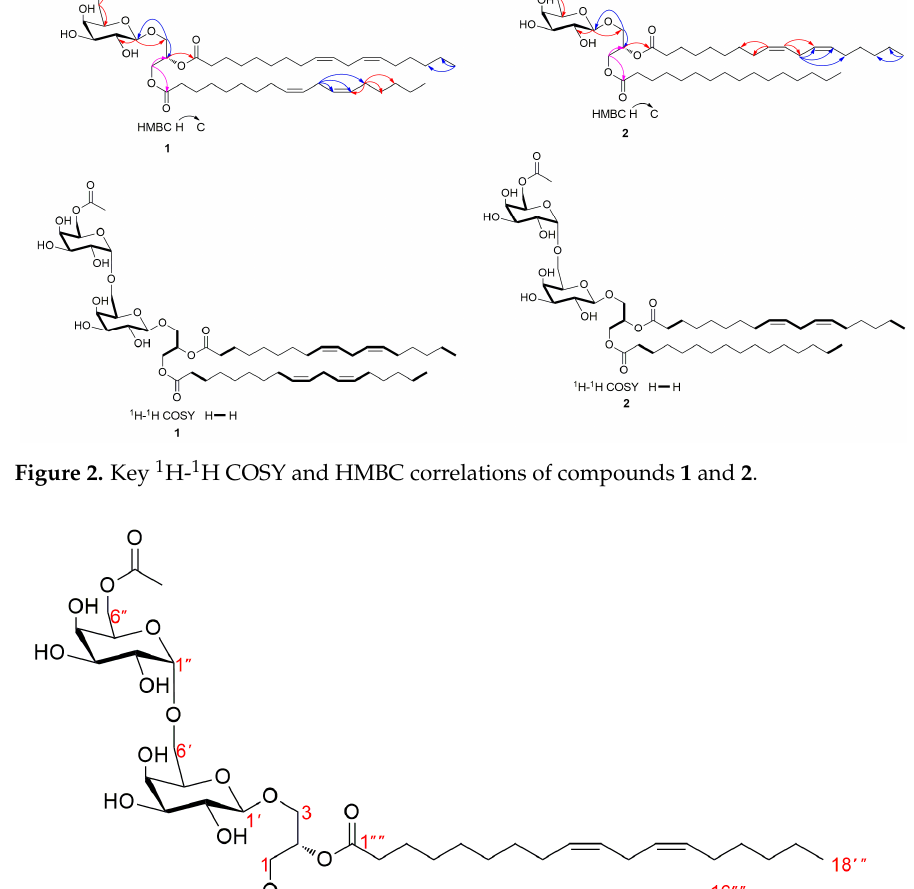
Figure 3. Chemical structures of compound 2 from Tubeufia rubra PF02-2.